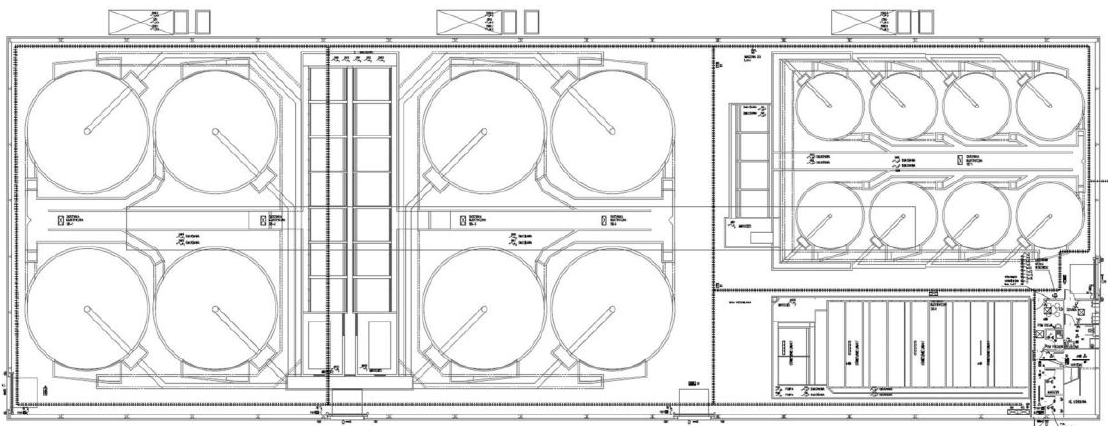
Figure 1. Schematic diagram of the production hall.